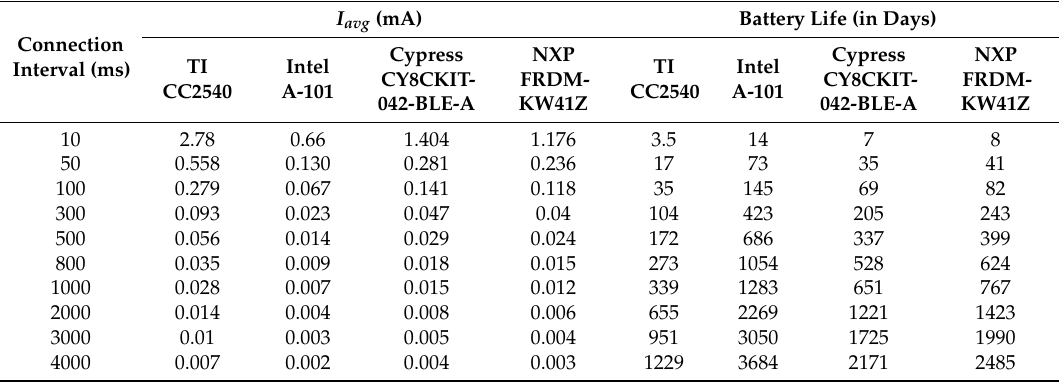
Table 5. Current consumption and expected battery life for each platform configured as PD for different connection